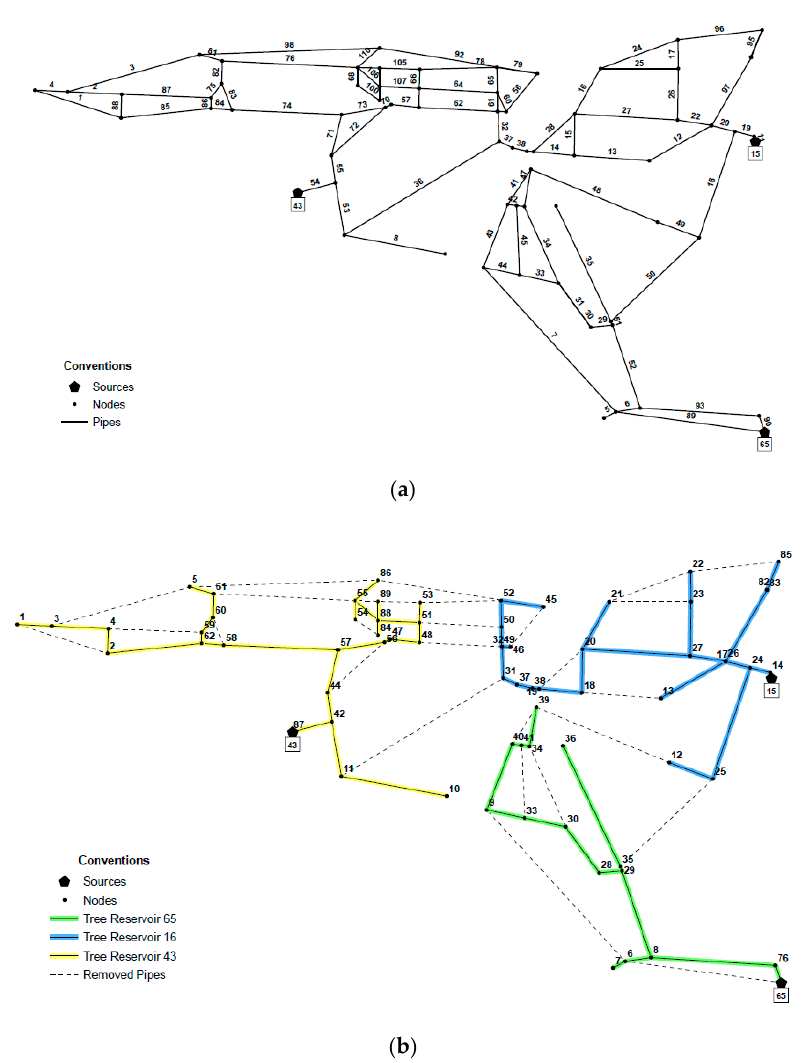
Figure 4. ( a ) Layout of Pescara Water Distribution System (WDS). Pipe ID shown in the labels above the pipes ( b ) Minimum-Cost Spanning Tree. Node ID shown in the labels. Dashed links correspond to the pipes that do not form part of the spanning tree.